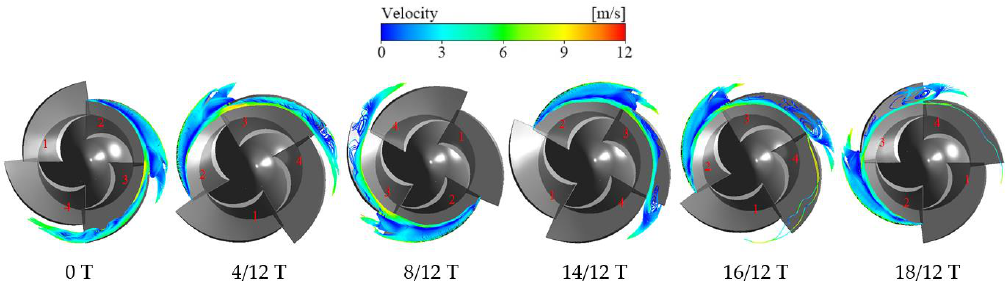
Figure 18. Velocity streamline diagram of leakage flow at different time ( δ = 0.5 mm).